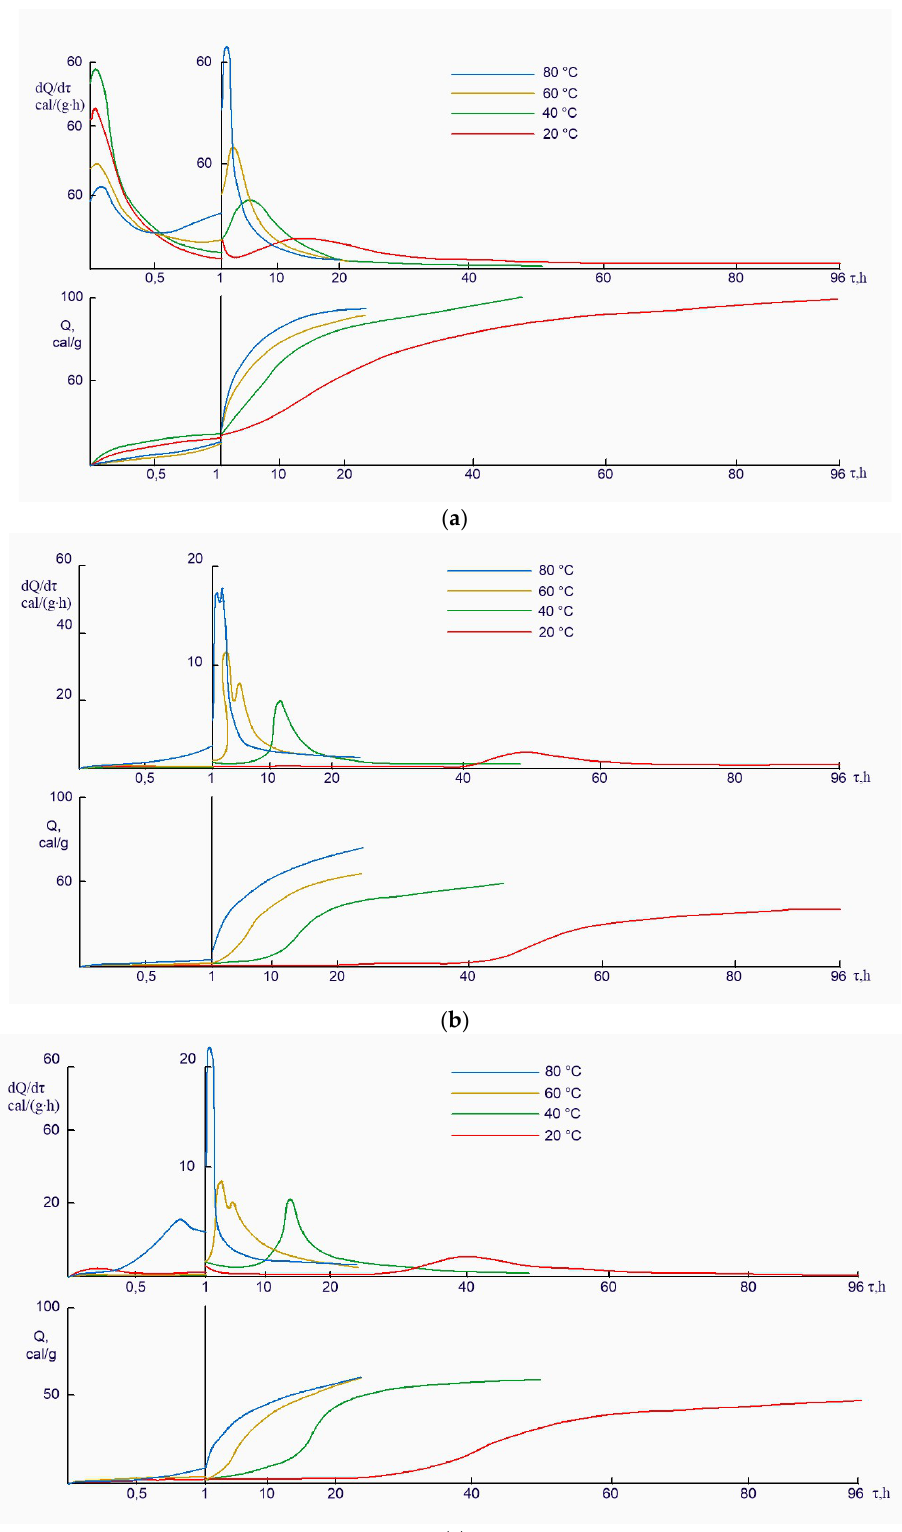
Figure 4. The comparative thermokinetic characteristics of cement hydration process at curing temperatures and in the systems: clinker + water ( a ); slag + solution of Na 2 O · SiO 2 · 5H 2 O ( b )